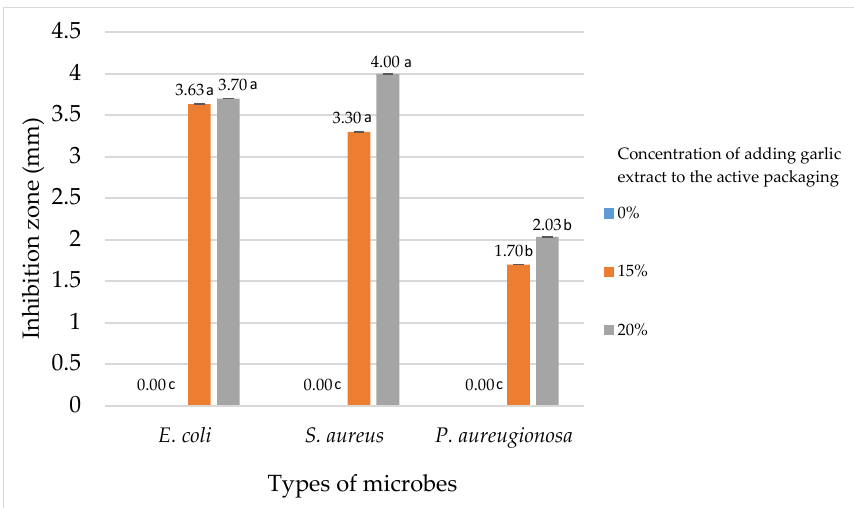
Figure 2. Diameter of bacterial growth barriers on activated paper. The mean value followed by different letters showed a significant difference based on the Tuckey’s test at the 5% level ( p -value < 0.05).